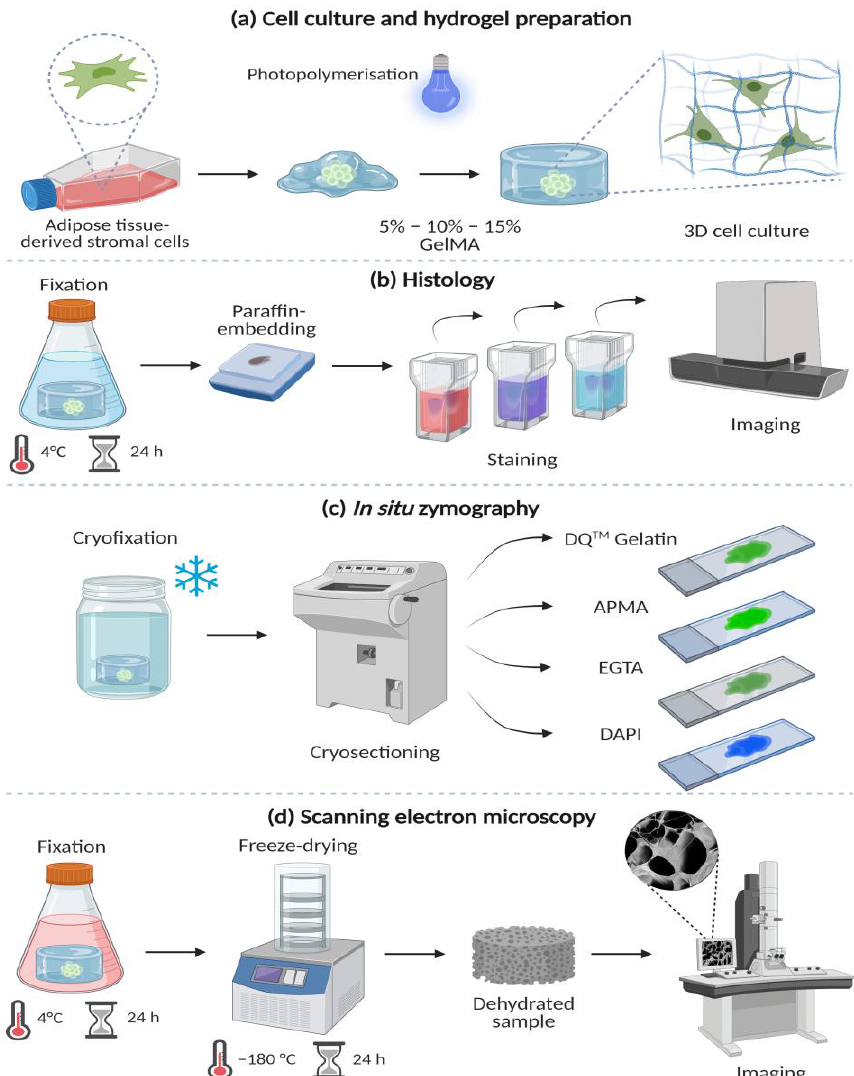
Figure 1. Methods: ( a ) Culture of adipose tissue-derived stromal cells (ASCs) and loading in 5%, 10%, and 15% gelatine methacryloyl (GelMA) hydrogels. ( b ) Histology stains after 4% formalin-fixed and paraffin-embedding. Sections (4 µm) were stained with hematoxylin and eosin (H&E), picrosirius red (PSR) and phalloidin/DAPI stains to observe the cellular morphology and distribution within the GelMA hydrogels. ( c ) In situ zymography to detect matrix metalloproteases (MMPs). Hydrogels were cryofixed (liquid nitrogen), cryosectioned (4 µm), and exposed to four different conditions: DQ TM Gelatin, DQ TM Gelatin/APMA (MMP activator) DQ TM Gelatin/EGTA (MMP inhibitor) and DAPI alone. Cell-free material was also stained. ( d ) Scanning electron microscopy (SEM) of GelMA hydrogels after fixation with 2% paraformaldehyde and 2% glutaraldehyde followed by freeze-drying and visualised at 1000× magnification. Created with biorender.com (accessed on 18 July 2022).